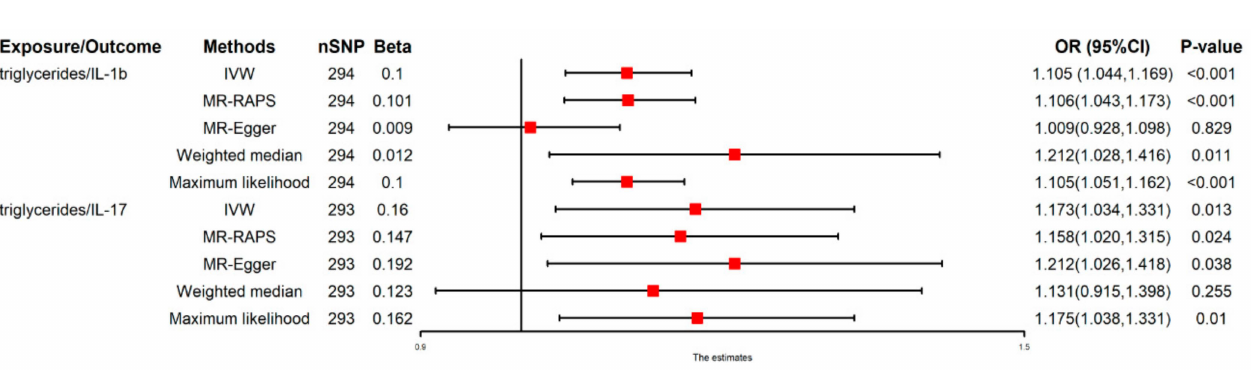
Figure 3. Casual effect of Tg on IL-1 β and IL-17. The red point means the effect (Beta).